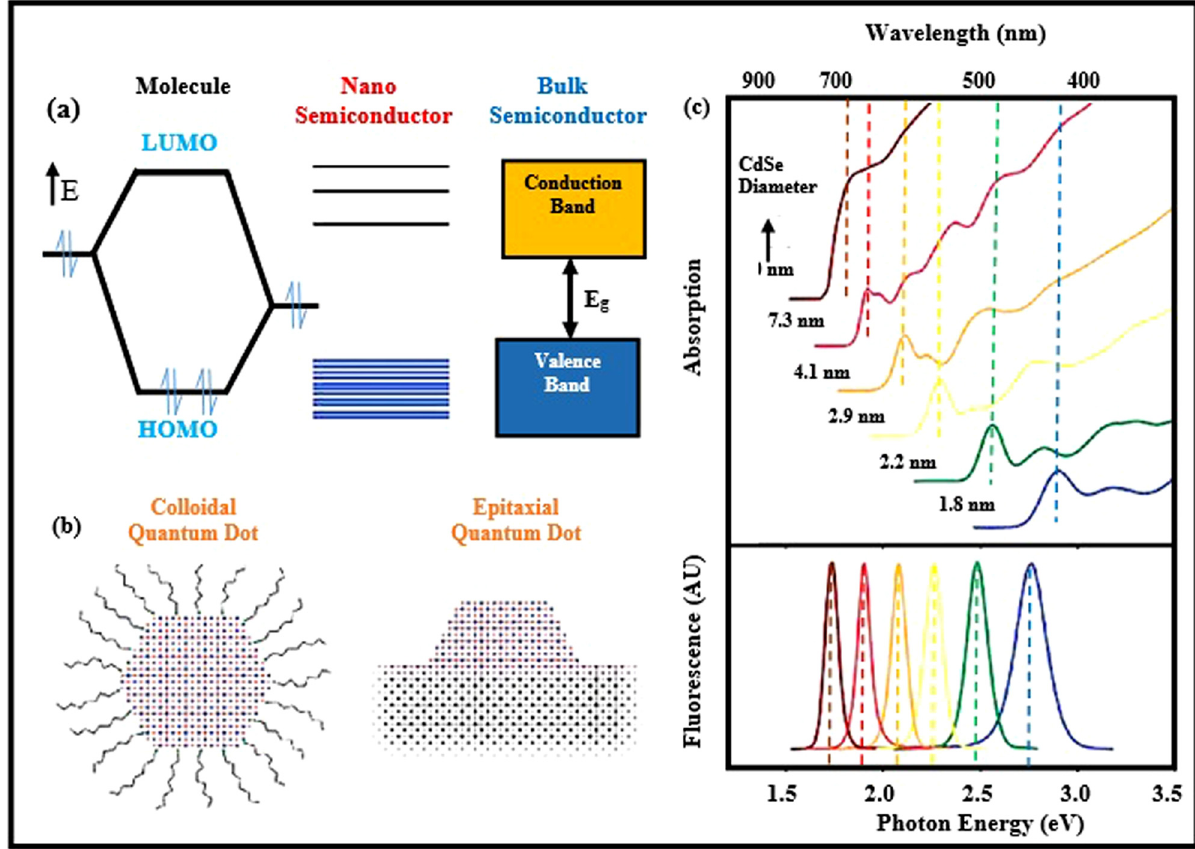
Figure 8: ( a ) The electronic energy transition from discrete molecules to nanosized crystals and bulk crystals, ( b ) comparison of a colloidal quantum dot and epitaxially quantum dot, and ( c ) absorption ( upper ) and fl uorescence ( lower ) spectra of CdSe semiconductor